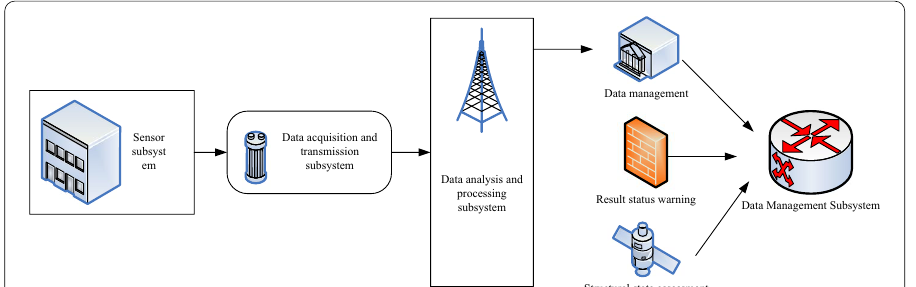
Fig. 2 Relationship between the sub-systems of the health monitoring